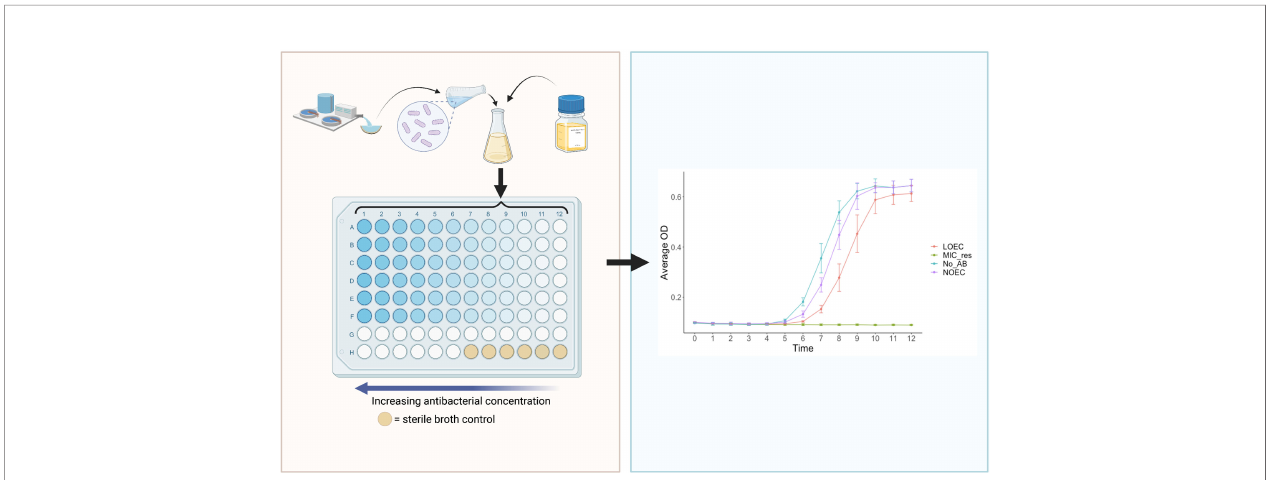
FIGURE 5 | The ‘ SELection End points in Communities of bacTeria ’ (SELECT) Method (Murray et al., 2020). Left: a schematic overview of the SELECT assay; a 96-well- plate containing Iso-Sensitest broth inoculated with a complex sewage community, exposed to two-fold dilutions of an antibacterial. Right: an expected graphical output of the SELECT method, showing complex bacterial community growth curves in response to different concentrations of antibacterials. The LOEC is identi fi ed where the growth of the community is signi fi cantly lower than the no-antibacterial control, at the time point which exhibits the strongest dose-response relationship. LOEC, Lowest Observed Effect Concentration; NOEC, No Observed Effect Concentration; MIC_res, minimum inhibitory concentration of resistant strains, No_AB, No Antibacterial control. Created with BioRender.com.